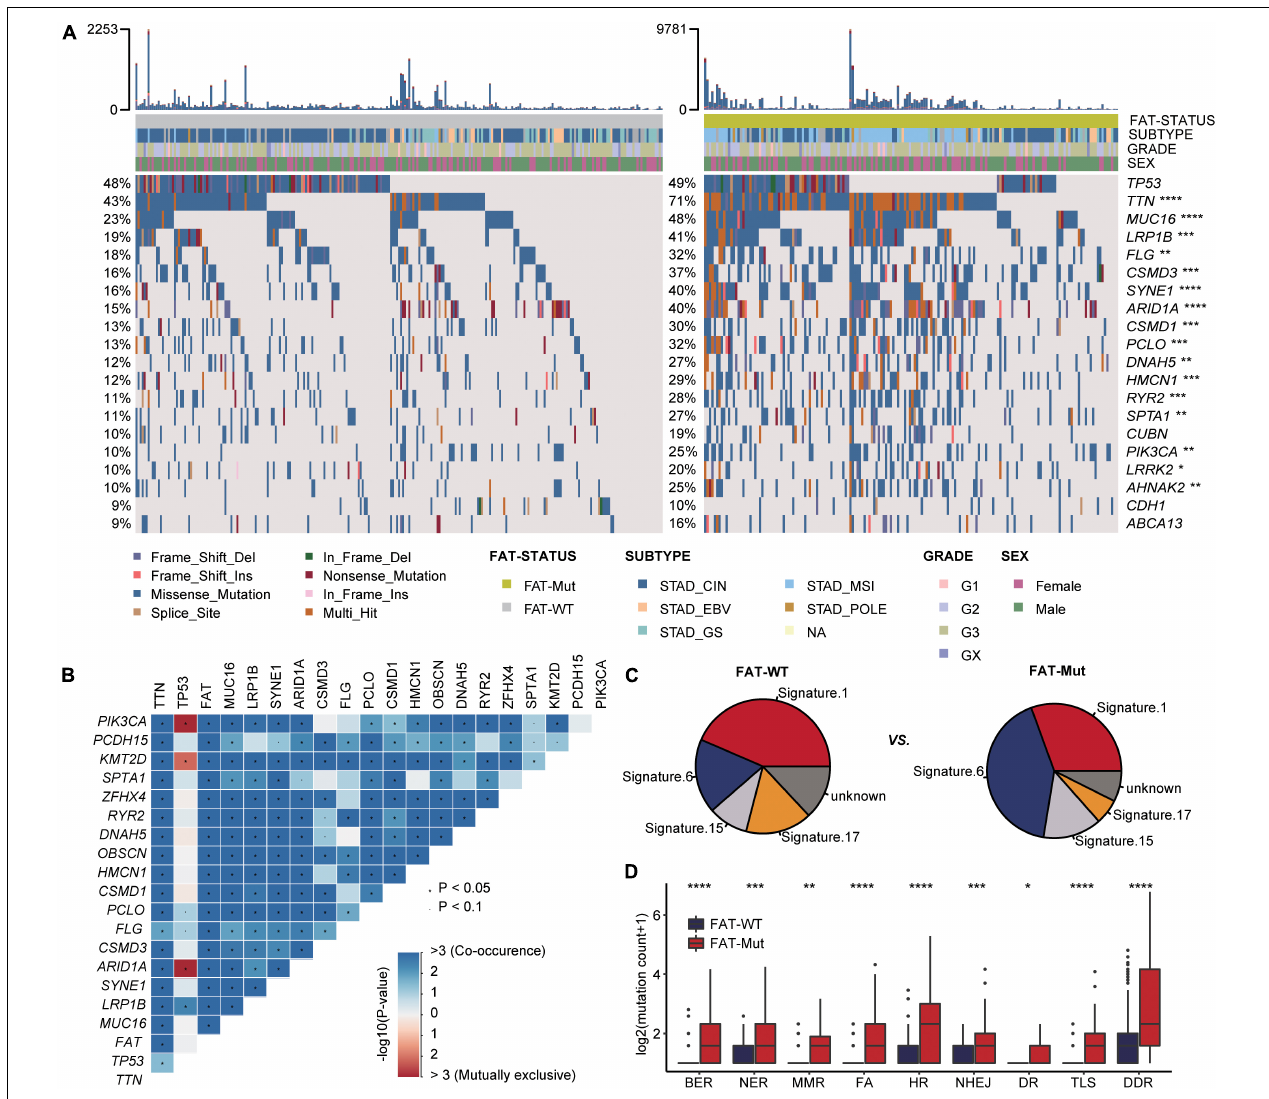
FIGURE 3 | Somatic mutation characteristics associated with FAT mutations. (A) Top 20 frequently mutated genes in the FAT-WT ( n = 261) and FAT-Mut ( n = 174) groups. Genes are ranked by mutation frequency of FAT-WT patients. The proportion of mutated genes was tested by Fisher’s exact test. TCGA, The Cancer Genome Atlas (* P < 0.05; ** P < 0.01; *** P < 0.001; and **** P < 0.0001; Fisher test). (B) Heatmap showing genes that are co-occurrent or mutual exclusive with mutated FAT in STAD. Red denotes mutual exclusivity, whereas blue indicates co-mutation. Fisher’s exact test was used to identify remarkable interactions, * P < 0.05. (C) The somatic mutational signature analysis. The proportion of total somatic substitutions in FAT-WT or FAT-Mut group contributed by each of the operative mutational signatures. (D) Comparison of DNA damage-related gene set alterations between FAT-WT and FAT-Mut patients with STAD. BER, base excision repair; NER, nucleotide excision repair; MMR, mismatch repair; FA, Fanconi anemia; HR, homologous recombination; NHEJ, non-homologous end joining; DR, direct repair; TLS, translesion synthesis (* P < 0.05; ** P < 0.01; *** P < 0.001; and **** P < 0.0001; Wilcoxon test).